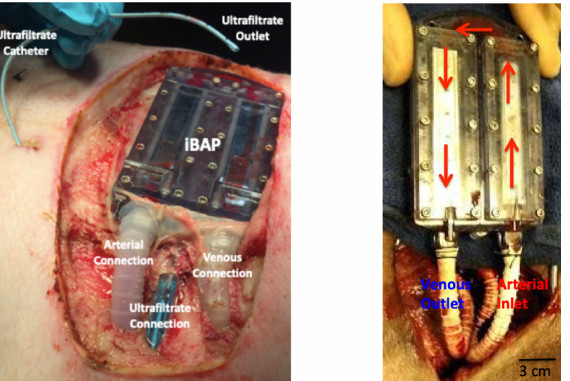
Figure 5. A prototype of an implantable Bioartificial Pancreas (iBAP) implanted into a porcine model.